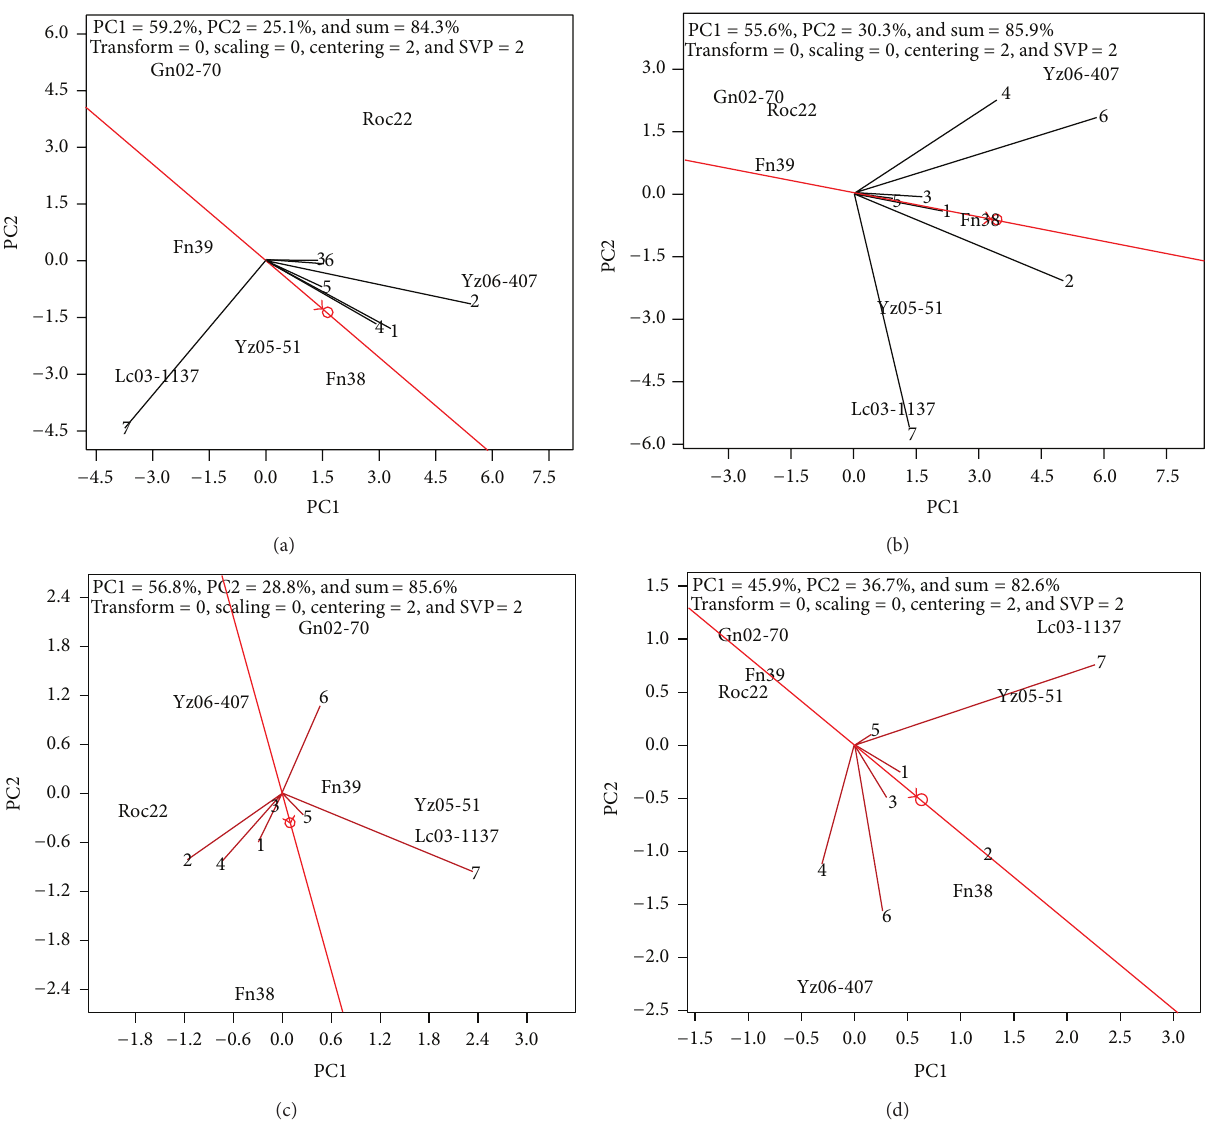
Figure 3: Representativeness and discrimination ability based on GGE-Biplot analysis. A line represents an environmental vector between original point and environment variance. An angle value between two lines (or vectors) represents the genetic correlation coefficient between the two. An angle value of < 90 ∘ indicates a positive correlation; an angle value of > 90 ∘ indicates a negative correlation; and an angle value of 90 ∘ indicates no correlation. Discrimination ability is measured by the line length of the environmental vector. The circle position depends on the average environmental value of all coordinate axes of the test sites; the single arrow red line connects the original point of bi-axis with average environmental value. Site representativeness is indicated by the angle between the single arrow red line and the site vector line. The smaller the angle, the stronger the representativeness. Refer to Figure 1 legend for Panel, PC1, PC2, numerical codes for evaluation sites, and codes for